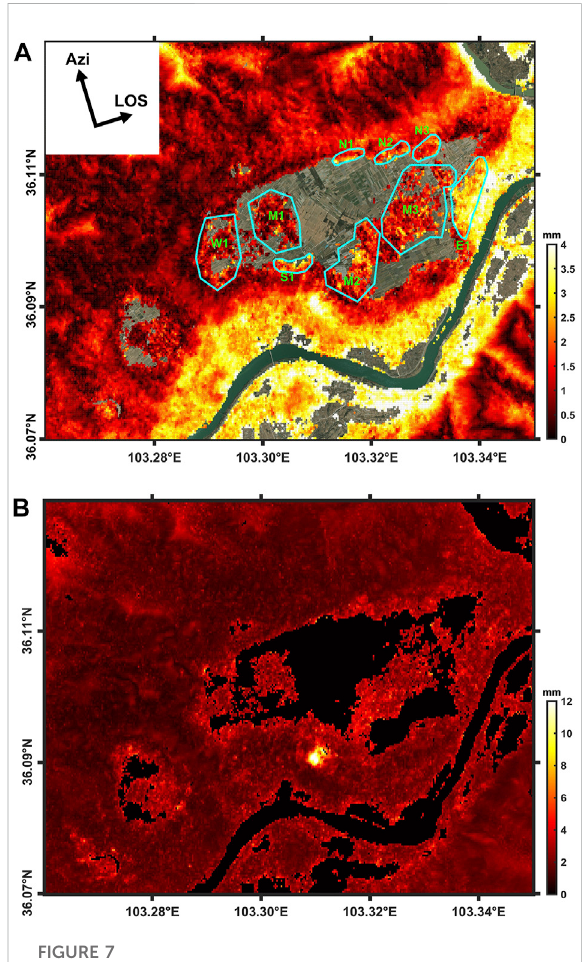
Spatial pattern of the amplitudes of seasonality (A) derived from time-series deformation from the ascending track, along with the root-mean-square error (RMSE) of model fi tting (B) . Nine areas on the platform with prominent values on amplitudes are enclosed with cyan solid lines, namely, W1 (west), M1-3 (middle), E1 (east), N1-3 (north), and S1 (south) according to their location in the terrace. The averaged time-series of pixels in those regions are prepared for the wavelet